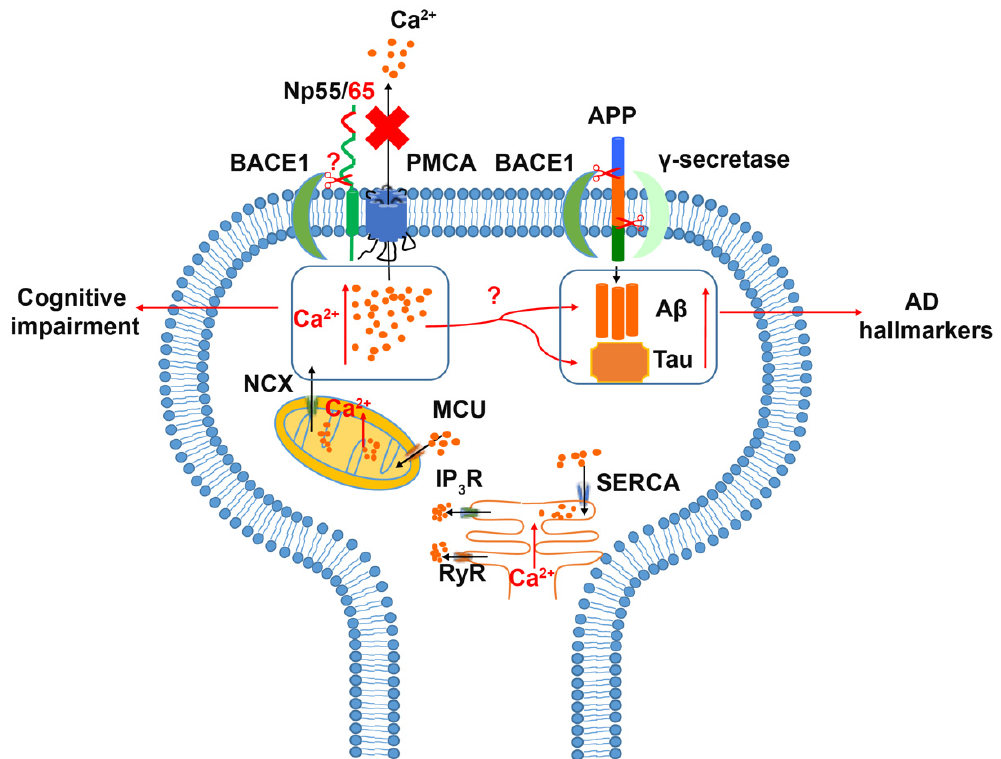
Figure 3. Relation of Neuroplastin to Alzheimer’s disease. The Amyloid Precursor Protein (APP) is cleaved aberrantly by β -secretase (BACE1) and γ -secretase resulting in A β . A β and tau are considered hallmarks of Alzheimer’s disease. Increased intracellular Ca 2+ concentrations are associated with cognitive impairment and increases in A β and tau. Intracellular Ca 2+ can be deposited into or released from mitochondria and ER as intracellular calcium stores. Energy driven extrusion of Ca 2+ is mediated by PMCAs. In the absence of neuroplastin, PMCA levels are reduced and intracellular Ca 2+ is increased. The hypothetical cleavage of neuroplastin by BACE1 may result in loss of PMCAs and elevated Ca 2+ levels.